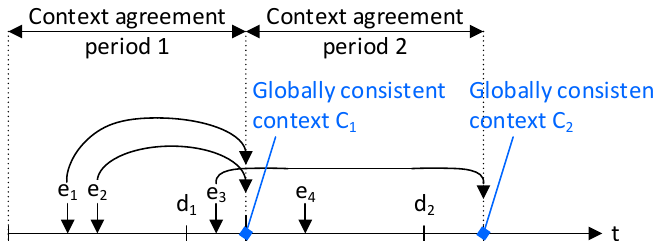
Figure 7. Events before the context reporting deadline d n of the respective period n are considered for the agreed context C n . Events happening between the agreement start and the agreed global context are considered for the next